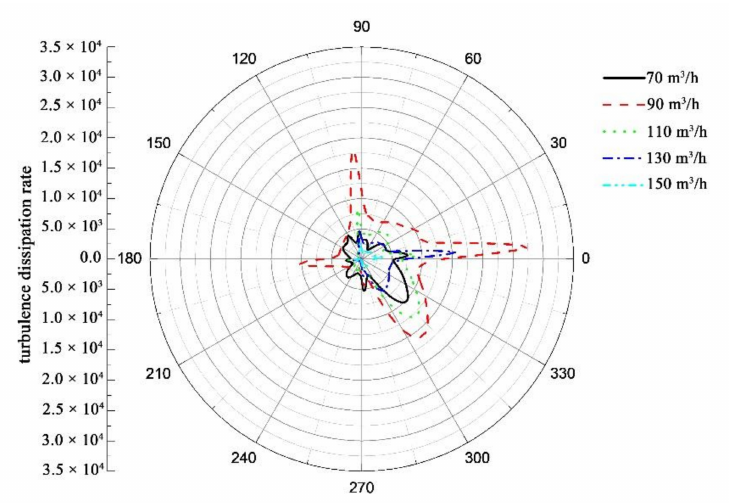
Figure 19. The variation of the circumferential turbulence dissipation rate at the outlet section 0.5 span within the first impeller under different flow rates.